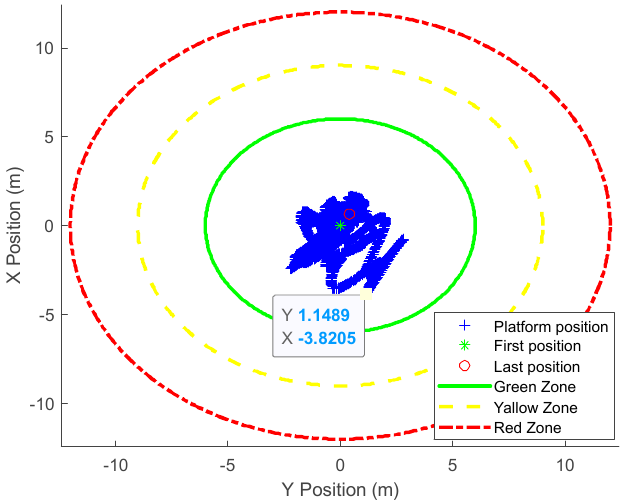
Figure 15. DP simulation with PID and PNN controls showing platform position (Head sea).